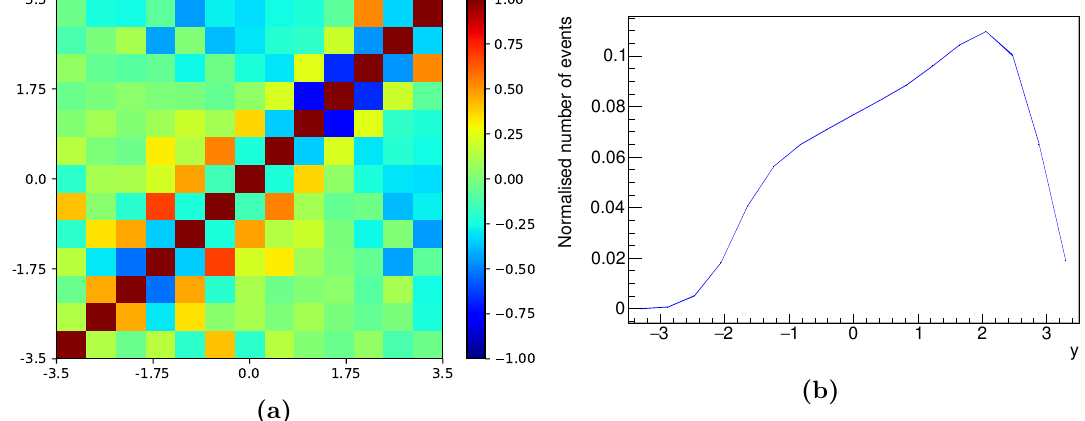
Figure 4 . a) Correlation matrix of the (cid:12)t b) Rapidity distribution for W + with spin pointing to the negative z axis as measured in the